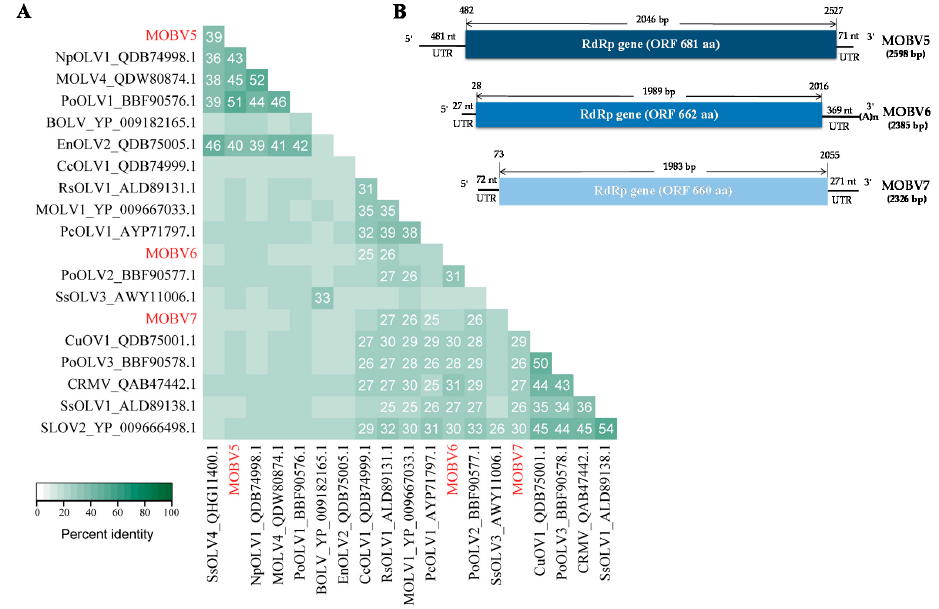
Figure 2. Analyses of three newly identified (+) ssRNA viral genomes and viruses belonging to the family Botourmiaviridae and the viral genome organization. ( A ) Percent identity matrix of the viral RdRP sequences generated by Clustal-Omega 2.1. Cutoff values were 25%. The viruses identified in this study are represented in red. ( B ) Schematic representation of the MOBV5, MOBV6, and MOBV7 genome organizations. Each virus contained a single open reading frame (ORF) encoding a putative RNA-dependent RNA polymerase (RdRp), and 5 (cid:48) and 3 (cid:48) untranslated regions